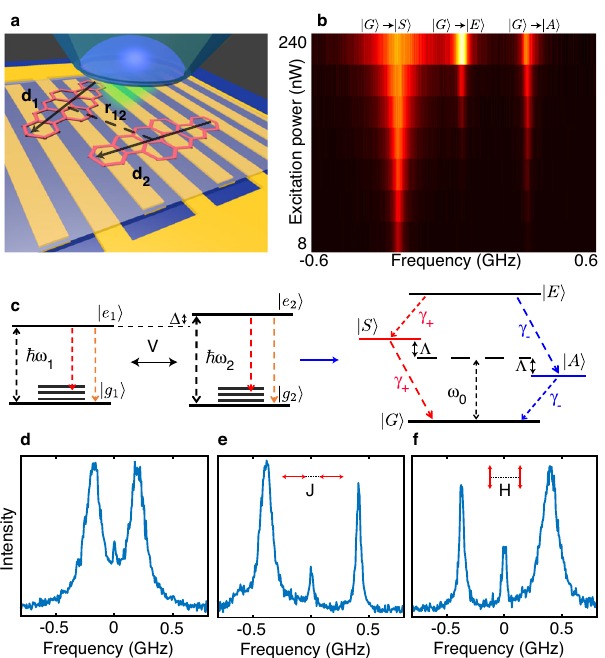
Fig. 1 Spectral signatures of coherently coupled pairs of molecules. Fig. 2 Manipulation of the degree of superposition by Stark effect. a Schematic of the sample. A highly doped naphthalene crystal doped with a , b Excitation spectra of a pair of molecules with nearly parallel dipoles in DBATT molecules is placed above a comb of micro-patterned gold electrodes the J-con fi guration and V ∼ γ 0 , recorded with an excitation intensity of 0.25 (period of 20 μ m) to apply electric fi elds up to few tens of MV m − 1 . A W cm − 2 . The applied electric fi eld shifts the molecular detuning from 10 γ 0 microscope objective with numerical aperture 0.95 is used to excite the ( a ) to 4 γ 0 ( b ). Lorentzian fi ts (red curves) of the subradiant (higher- molecules on their ZPLs and collect the red-shifted emitted photons. b Series energy) ZPL gives a FWHM linewidth of 22 MHz in ( a ) and 13 MHz in of fl uorescence excitation spectra recorded for a pair of coupled molecules at ( b ). The inset in b displays the spectral trails of this pair as the voltage is different excitation intensities ranging from 2 W cm − 2 to 250 W cm − 2 . The swept from 0 (top) to 150 V (bottom). c , d Zoomed-in ZPLs of the onset of a two-photon transition | G 〉 → | E 〉 shows direct evidence of coherent subradiant ( c ) and the superradiant ( d ) states of another molecular pair dipole – dipole interaction. c Left: Energy levels of two bare molecules. Besides with nearly parallel dipoles in the H-dipole con fi guration and V ~ 15 γ 0 . The the purely electronic transition (orange arrows), the vibrational levels may be powers of the Gaussian illumination are respectively 0.1 nW and 0.3 nW. involved in the fl uorescence process (red arrows) but do not participate to The red curves are Lorentzian fi ts with FWHM linewidths (13.9 ± 0.6) MHz the coherent coupling due to fast relaxation to the ground electronic state (on and (33.0 ± 1.6) MHz, respectively. e Saturation plots (blue disks) and fi ts the picosecond timescale). Right: The coupled molecules are treated as a (red curves) of these ZPL linewidths. Radiative rates γ − /2 π = 15.3 ± 0.5 four-level system with a ground state | G 〉 , a doubly excited state | E 〉 and two MHz and γ + /2 π = (33.0 ± 0.5) MHz are derived from the fi tting saturation split entangled states | A 〉 and | S 〉 . d – f Excitation spectra of three different pairs intensities. The horizontal dashed line at 23 MHz marks the average of coupled molecules with various coupling strengths and dipole orientations. linewidth of single DBATT molecules at low excitation intensities. The symmetric state | S 〉 is associated with in-phase dipoles. In the H- f , g Experimental ( f ) and simulated ( g ) Stark-tuned spectral trails of a con fi guration, the electric fi eld created by one dipole is parallel and in-phase coupled pair of molecules under an excitation intensity of 200 W cm − 2 . opposition with the second dipole, so that the energy shift − d 2 . E 1 ( r 2 ) of the | The experimental spectra have been recentered on the two-photon S 〉 state is positive. In the J-con fi guration, the electric fi eld is parallel and in transition, while the raw spectral trails are presented in Supplementary phase with the dipole so that the energy shift of the | S 〉 state is negative. Fig. 7. The applied voltage is limited to the range − 150 to 150 V by electrode breakdown. As the system is tuned towards the anti-crossing point, the two-photon transition gains weight, the superradiant ZPL widens and the subradiant ZPL narrows with vanishing fl uorescence amplitude. The simulations are performed for a H-dipole con fi guration leading to maximal entangled delocalized states: A symmetric, superradiant state | S 〉 = superposition at the anti-crossing point. 2 ab γ 12 and an antisymmetric, subradiant state | A 〉 = a | e 1 , g 2 〉 − b | g 1 , e 2 〉 with reduced radiative decay rate γ − = γ 0 − 2 ab γ 12 (Fig. 1c). ^ : ^ d Manipulating the degree of superposition by Stark effect . Since ¼ αγ ð Þ arises from the d The cross-damping rate γ 1 2 12 0 fl uorescent molecules are trapped in the host matrix with fi xed incoherent coupling of the bare molecules through the vacuum ffiffiffiffiffiffiffiffiffiffiffiffiffiffiffiffiffiffiffi p positions and orientations that set their coupling strength V , the Δ 2 þ 4 V 2 fi eld 44 . The states | S 〉 and | A 〉 are split by 2 Λ ¼ and degree of superposition in the states | S 〉 and | A 〉 can be tuned only have projections a ¼ by adjusting their resonance frequencies. Manipulation of this q degree of superposition by Stark shifting the molecular transitions on the bare states 45 , which provide a with a static electric fi eld is demonstrated in Fig. 2 and Supple- measure of the degree of electronic state superposition. Maximally mentary Fig. 4. The spectrum in Fig. 2a presents the two ZPLs of entangled states (Bell states | Ψ Bell 〉 ) corresponding to a ¼ b ¼ a coupled molecular system (in the J-con fi guration) consisting ffiffiffi p of two largely detuned molecules (| Δ | ≫ | V |). These lines dis- 1 = 2 can be reached when the detuning between the bare playing similar widths and comparable amplitudes arise from the molecules is such that | Δ | ≪ | V |. NATURE COMMUNICATIONS| (2022) 13:2962